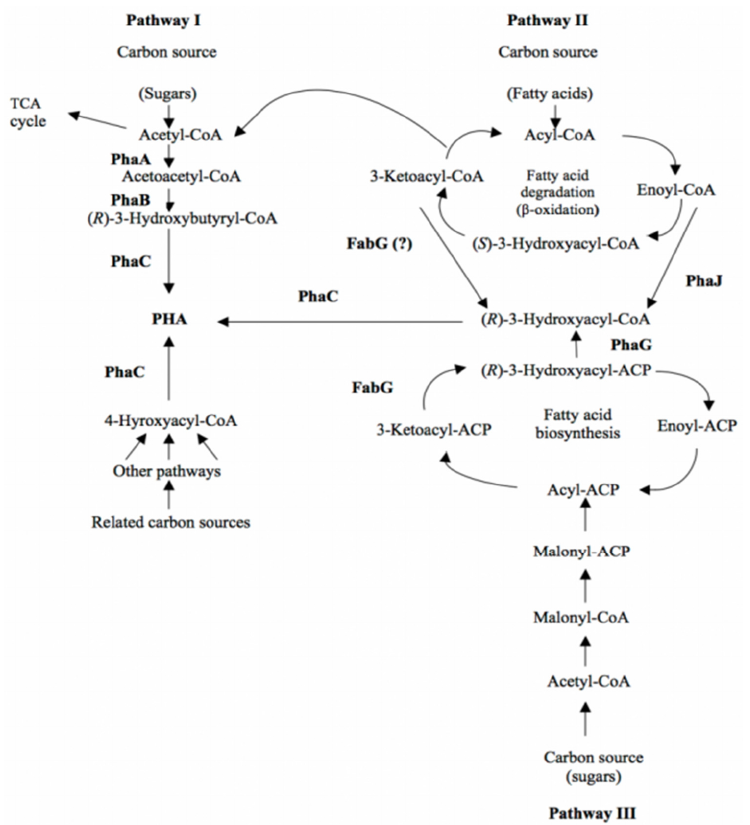
Figure 2. Metabolic pathways of PHAs biosynthesis [Ref. [45], available online: https://www.ecobiomaterial.com/pha/ accessed on 1 December 2021] .